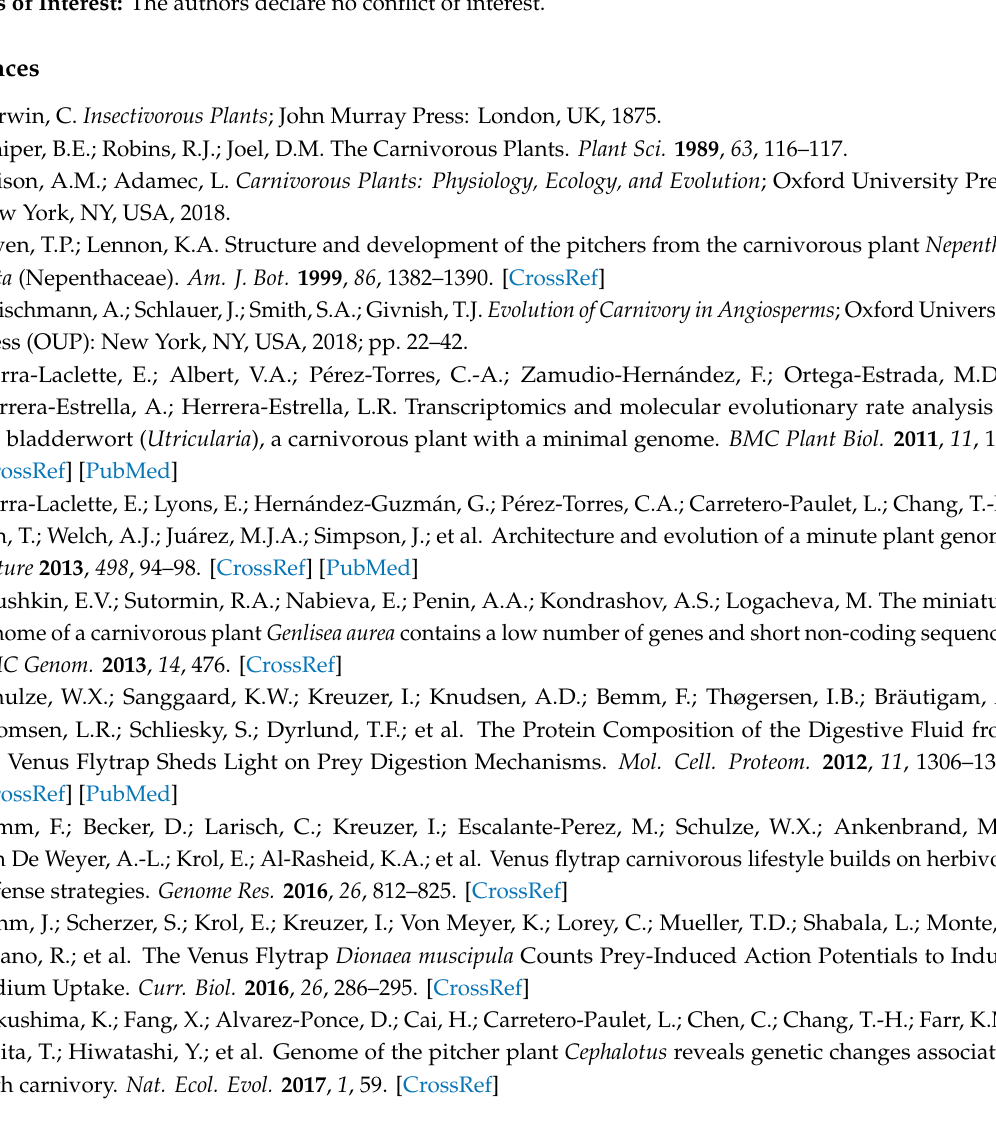
Figure S1: PCA Scores vs. m / z ; Figure S2: Heatmap of polar DAFs; Figure S3: Heatmap of non-polar DAFs; Figure S4: The m / z plots; Figure S5: Fold-change density plot; Figure S6: Heatmap of polar DAFs in pitchers due to feeding status; Figure S7: Feeding fold-change density plots; Figure S8: Quality control injections in the lipidomics experiment; Figure S9: Quality control injections in the polar experiment, injecting the raw extracts; Figure S10: Quality control injections in the polar experiment, injecting the ten-fold diluted extracts; Table S1: Polar fingerprints; Table S2: Non-polar fingerprints; Table S3: Features. Raw data was deposited in